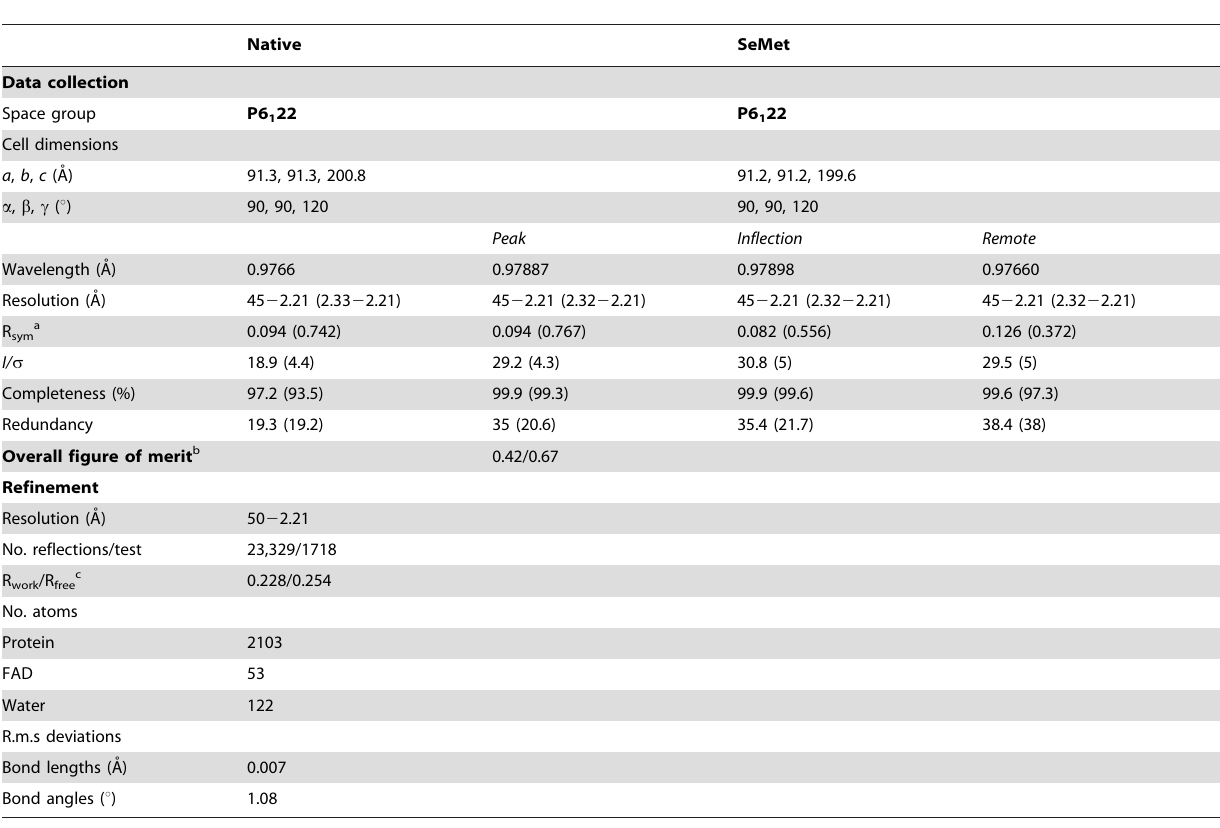
Table 1. Data collection, phasing, and refinement statistics for mimivirus R596-4C.